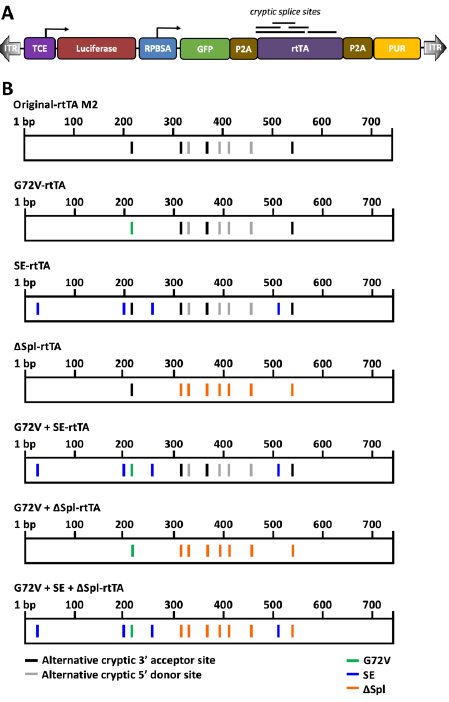
Figure 2. Overview of rtTA constructs investigated in this study. ( A ) Schematic of construct design derived from the original pSBtet-GP developed by Kowarz et al. ITR: inverted terminal repeat; TCE: tetracycline responsive promoter; GOI: gene of interest (firefly luciferase); PA: polyadenylation site; rtTA: reverse tetracycline-controlled transactivator. ( B ) Summary of rtTA constructs utilised within this study: Original-rtTA M2 (wildtype); G72V-rtTA; SE- rtTA; ΔSpl -rtTA; G72V + SE-rtTA; G72V + ΔSpl - rtTA; and G72V + SE + ΔSpl -rtTA. Black indicates predicted alternative cryptic 3′ acceptor sites; grey indicates predicted alternative cryptic 5′ donor sites; green indicates G72V mutation; blue indicates SE mutations; and orange indicates ΔSpl mutations.